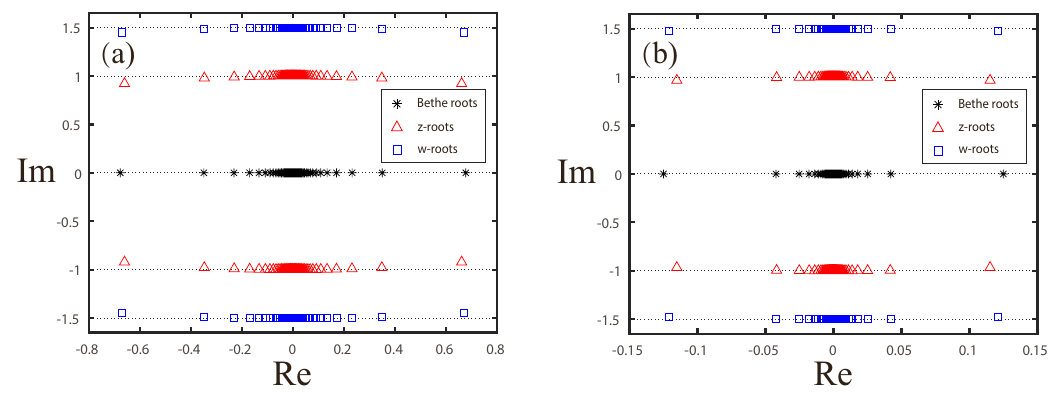
corresponding to the zeros of W ( Q ) ( u + η 2